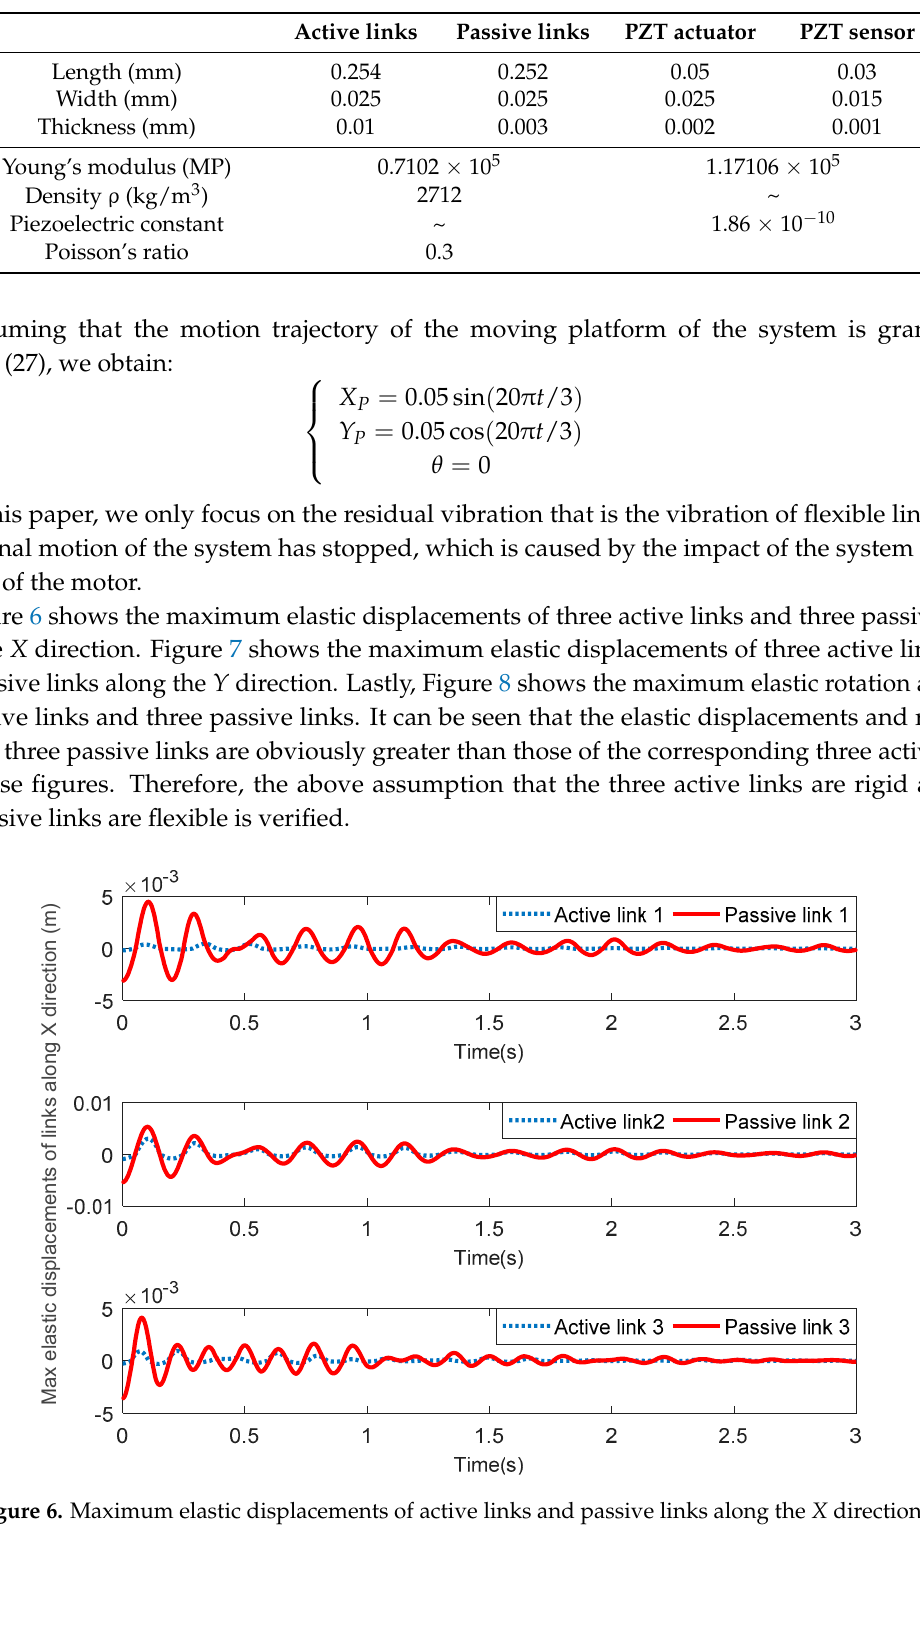
Table 1. Parameters of the components of the 3-RRR system.